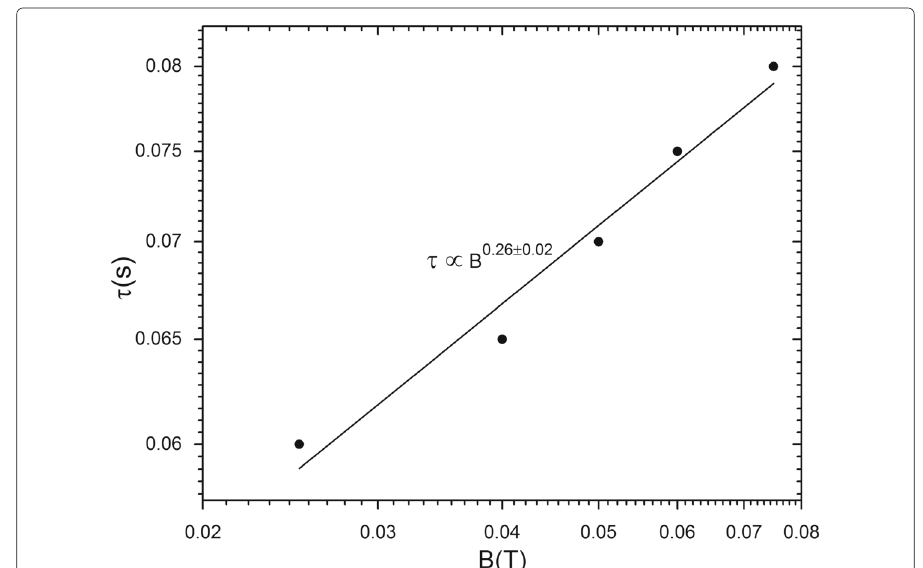
Fig. 11 Confinement time dependence on magnetic field with induced geometric distortions